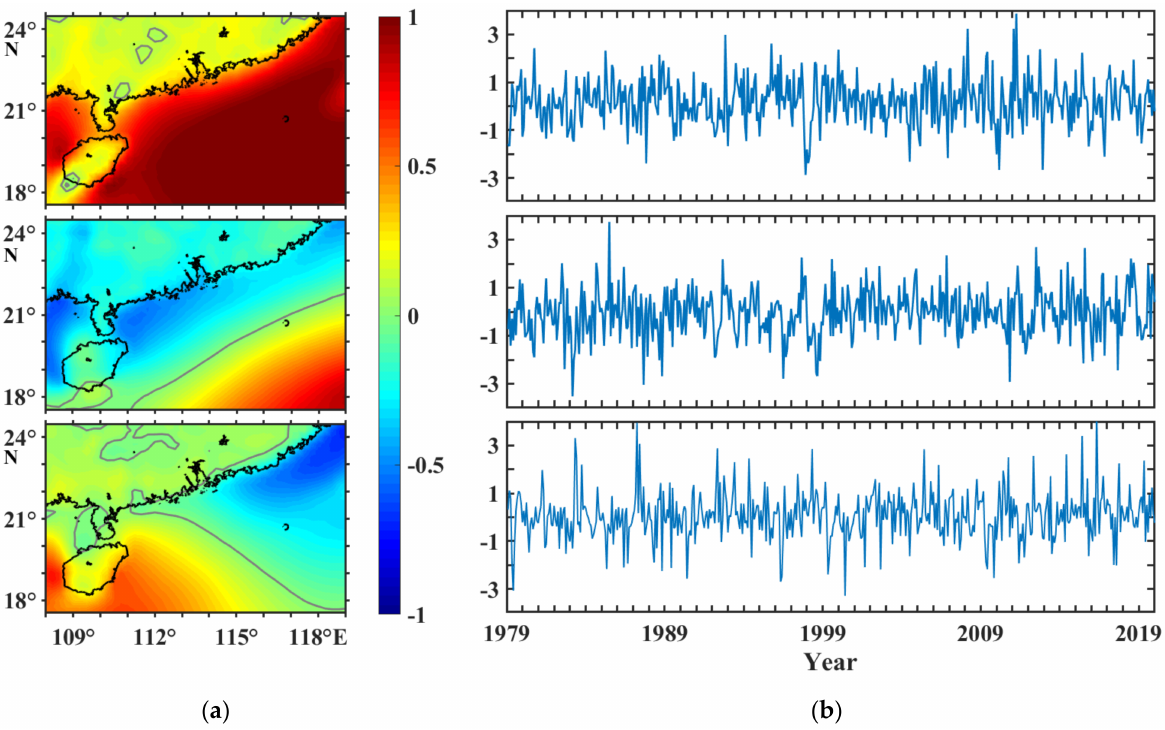
Figure 8. Spatial distribution of the eigenvectors and corresponding time coefficients of the first ( upper ), second ( middle ) and third ( bottom ) modes of the wind field empirical orthogonal function decomposition in the northern South China Sea. ( a ) Spatial distribution of eigenvectors; grey contours represent 0. ( b ) Time